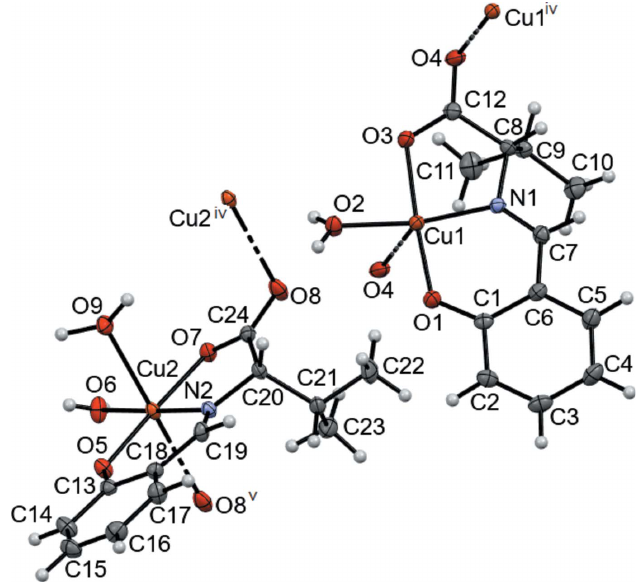
Figure 1 The molecular structure of the title compound. Displacement ellipsoids are drawn at the 50% probability level. [Symmetry codes: (iv) x (cid:5) 1, y , z ; (v) x + 1, y , z